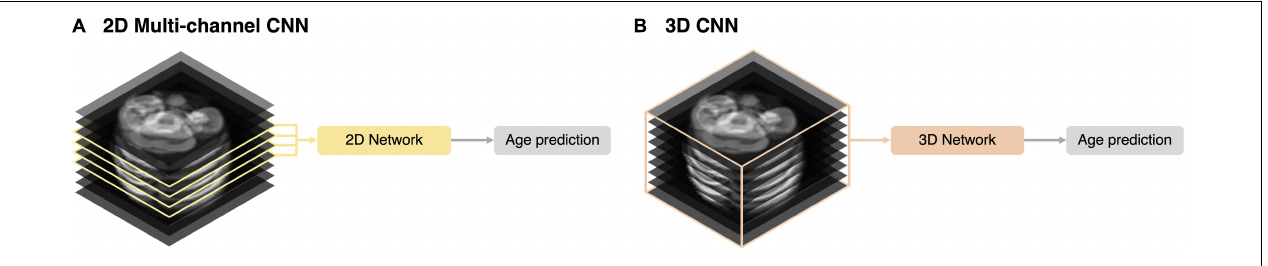
FIGURE 3 | Schematic representation of the input strategies. (A) 2D multi-channel. (B) 3D volume